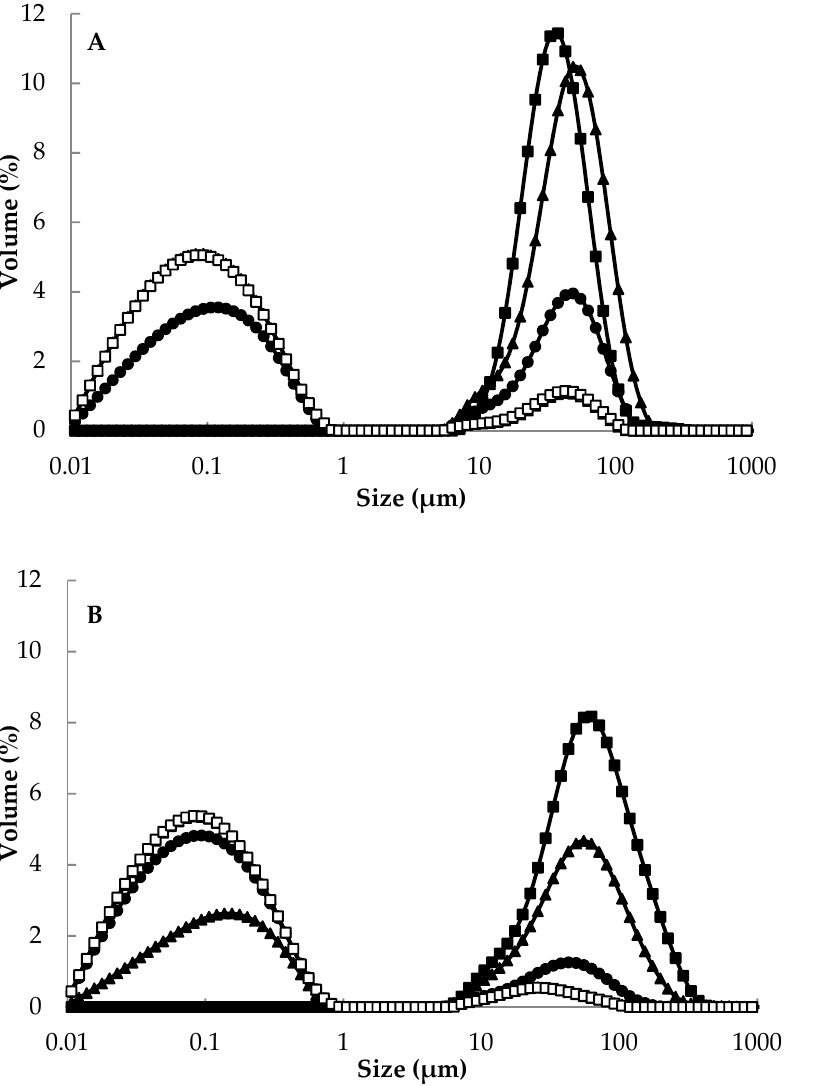
Figure 4. Particle size distribution of milk protein concentrate (MPC) 85 ( ■ ), MPC75 ( ▲ ), MPC65 ( ● ), MPC55 ( □ ), and MPC40 ( ∆ ) powders after reconstitution in ultrapure water at ( A ) 23 °C and ( B ) 50 °C. The volume of primary particles generally decreased with the reducing protein content of the powders. MPC55 and MPC40 displayed the highest dispersibility, which corresponded to a small volume of large particles in the range of 5–100 µ m, and a larger volume of sub-micron ( < 1 µ m) particles. Additionally, the D [4,3] value generally decreased as the protein content of the powders was reduced, e.g., 51.7 µ m for MPC75 compared with 4.25 µ m for MPC40 when the samples were reconstituted ◦ at 23 C (Table 4). The target particle size profile for a rehydrated MPC would be a monomodal distribution in the size range of casein micelles, (i.e., < 1 µ m). It has been reported that a mean particle size of 0.08–0.2 µ m represents the presence of casein micelles, providing evidence that the hydration of powder particles has taken place